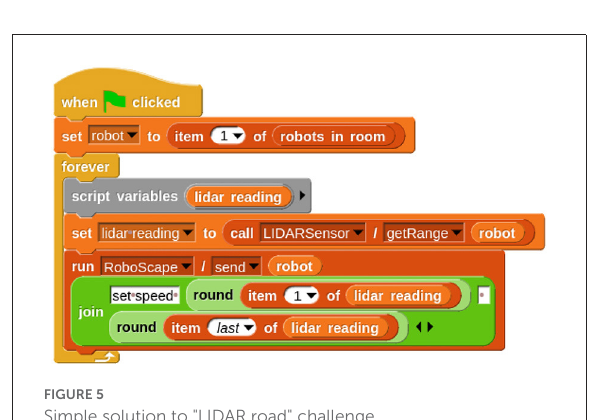
FIGURE5 Simple solution to "LIDAR road"